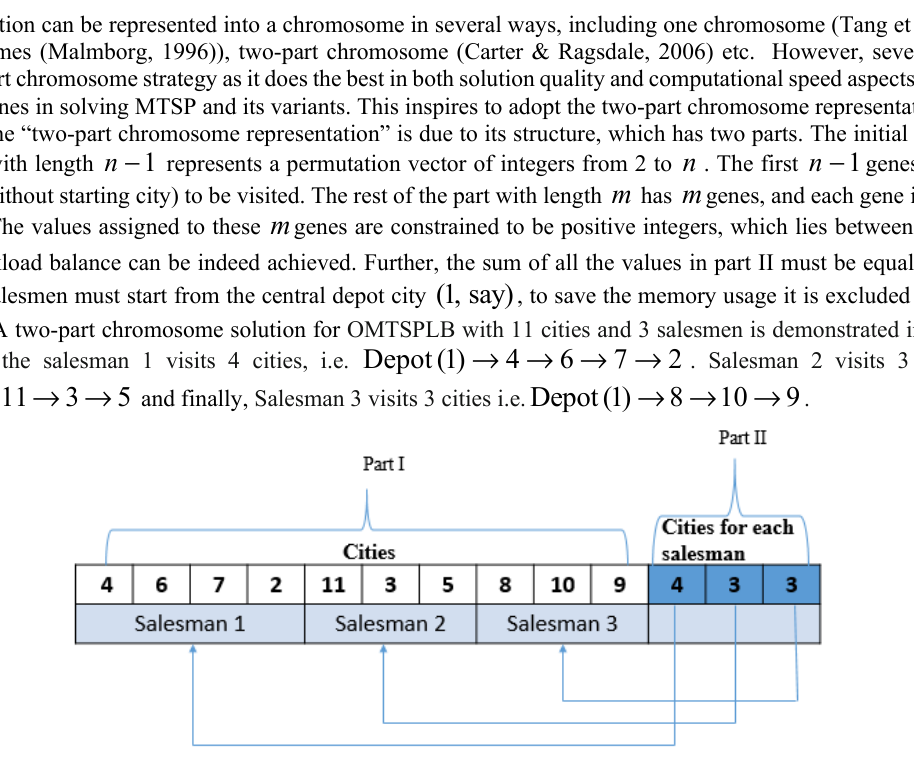
Fig 3. Representation of two-part chromosome for a 11 city OMTSPLB with 3